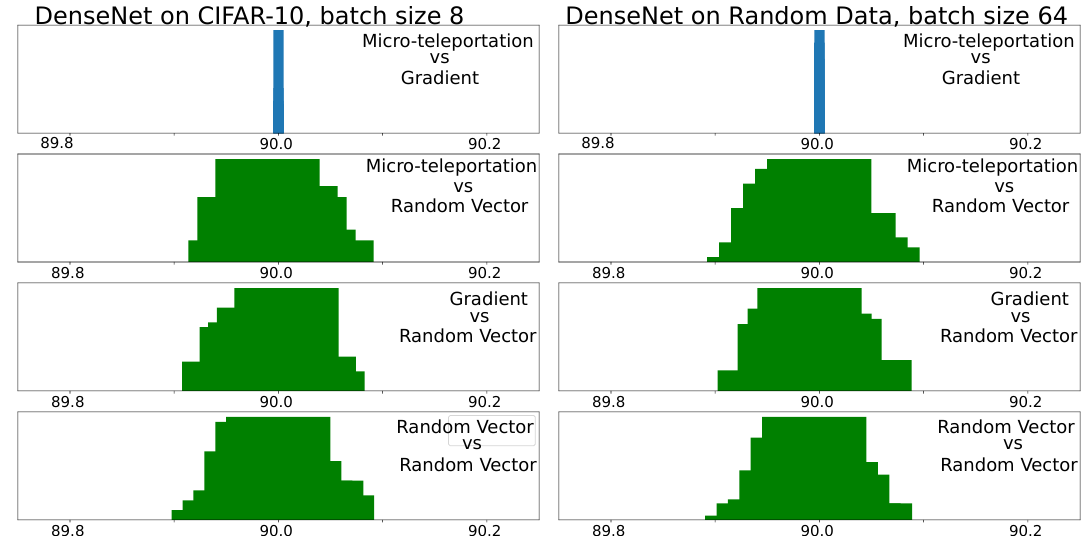
Figure A3. Micro teleportations experiments for DenseNet on CIFAR-10 and random data.